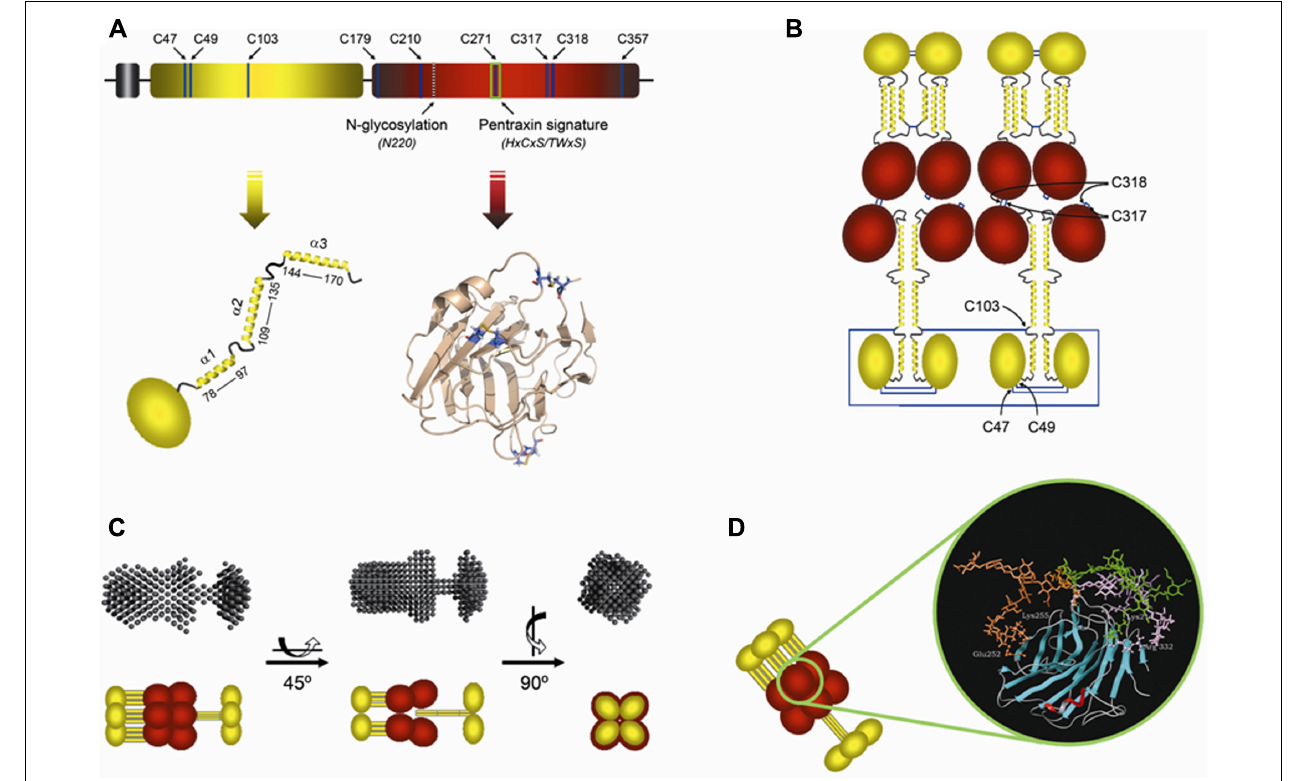
FIGURE 1 | Model of the PTX3 protein and its glycosylation. (A) Schematic representation of the PTX3 protomer subunit showing the N-terminal domain in yellow, followed by the globular pentraxin domain in red. Positions of the Cys residues, the N-glycosylation site at Asn220 and the pentraxin signature motif are indicated. Arrows point to a topological drawing of the N-terminal domain, which is believed to be composed of a globular region and three α -helical segments ( α 1, α 2, and α 3), and a three-dimensional model of the C-terminal pentraxin domain based on the crystal structure of C-reactive protein (Protein Data Bank ID: 1b09). (B) Disulfide bond organization of the PTX3 octamer. Highlighted are the Cys residues that participate in disulfide bond formation.The α -helical regions of the N-terminal